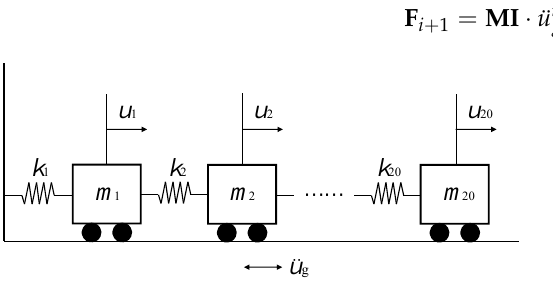
Figure 2. A 20-DOF spring-mass system. Table 1. The fundamental frequencies of the models